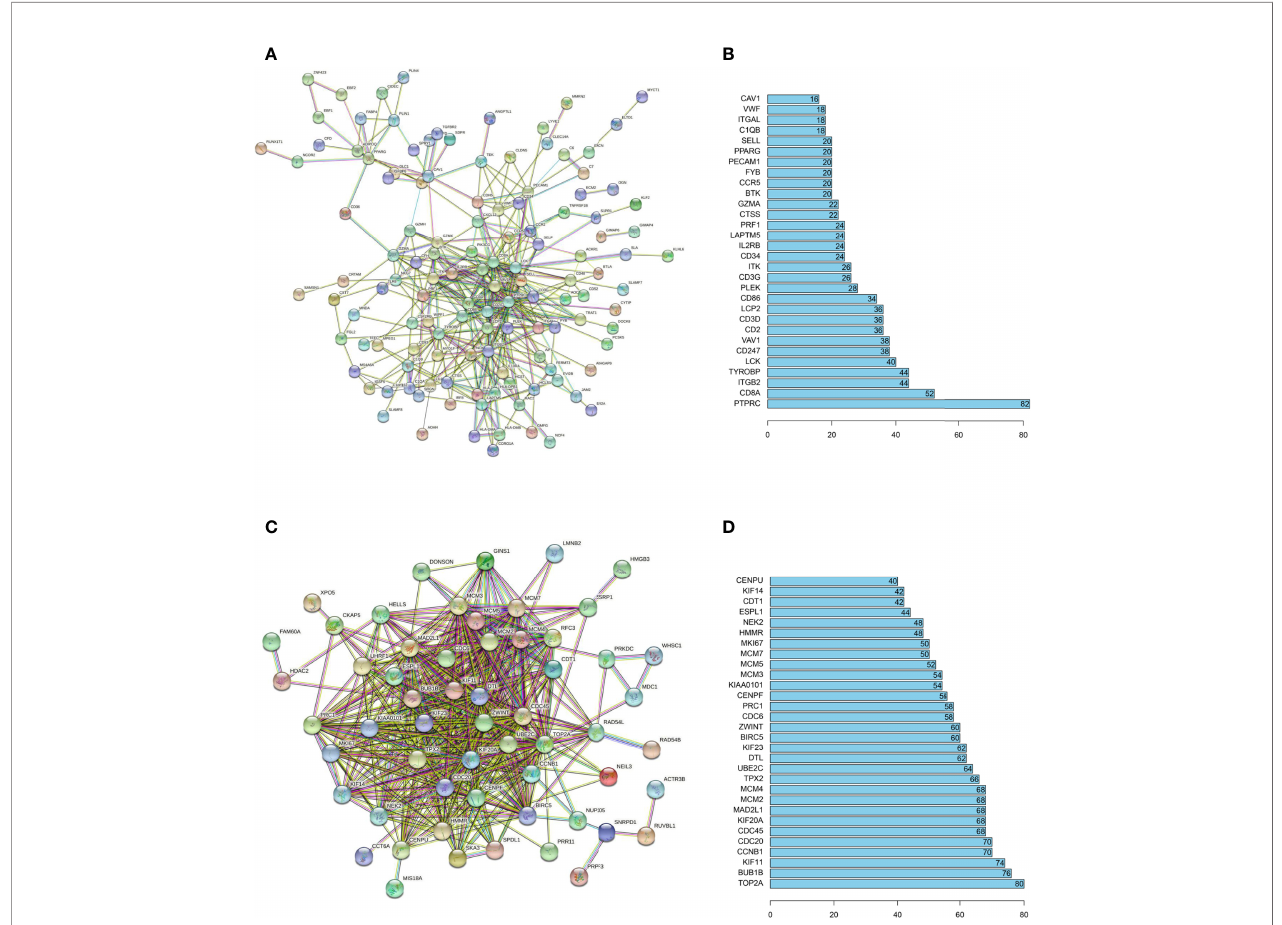
FIGURE 3 | PPI networks analysis for immune related hub genes. PPI networks were drawn by STRING (URL: https://string-db.org/) for hub proteins positive- (A) and negative- (C) related to immune in fi ltration. The minimum interaction score was set at 0.7. The disconnected nodes were not shown in the network. The number of connections was also listed for hub proteins of the immune positive- (B) and negative- (D) related hub